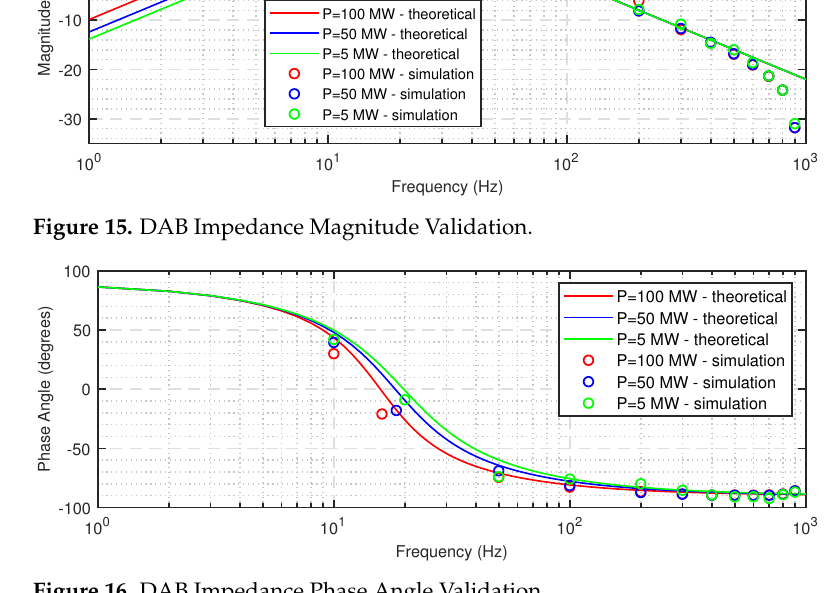
Figure 16. DAB Impedance Phase Angle